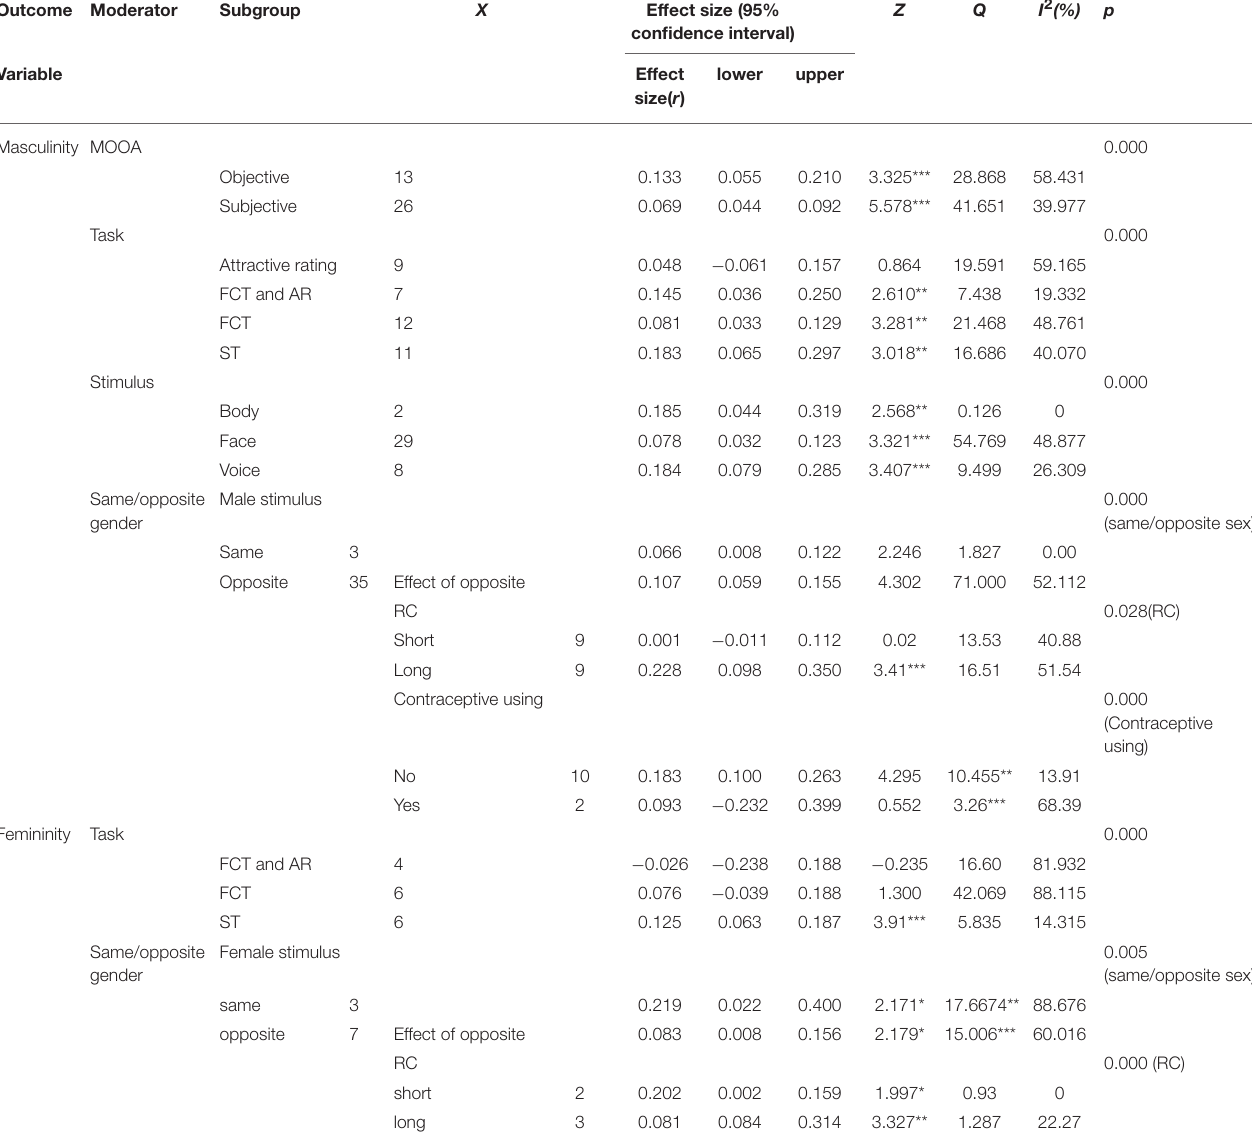
TABLE 2 | Summary of the results of the sub-group